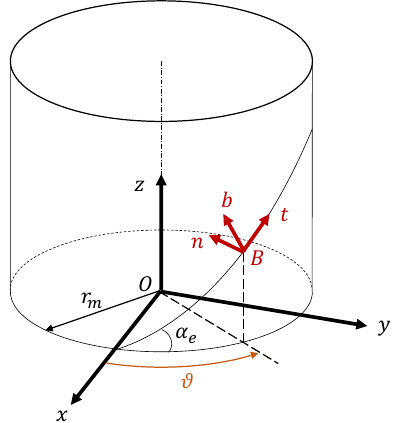
Figure 1. A ball screw’s main reference